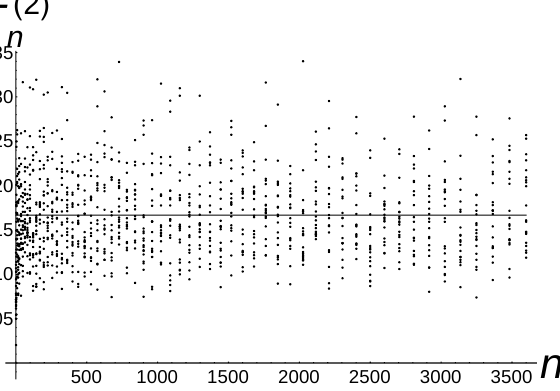
Γ ( 7 ) ( 3/2 ) ∼ 4 n 1 4 of Algorithm 5 with the additional theoretical line according to the Figure 9. T n 2 3 4 ( 5 2 ) leading term of Theorem 2 for a = 3/2.